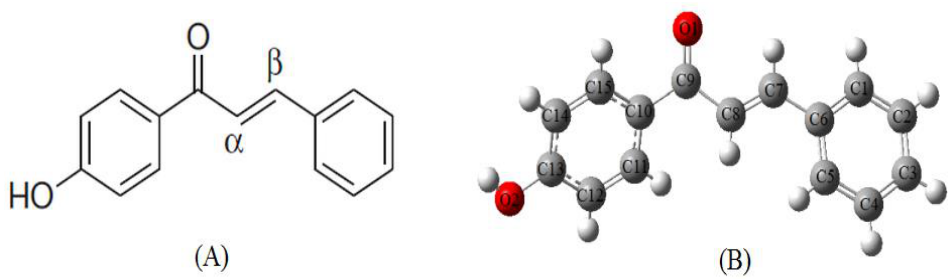
Figure 1. Chemical molecular structure ( A ) and optimized structure ( B ) for 1-(4-Hydroxyphenyl)-3-phenylprop-2-en-1-one.